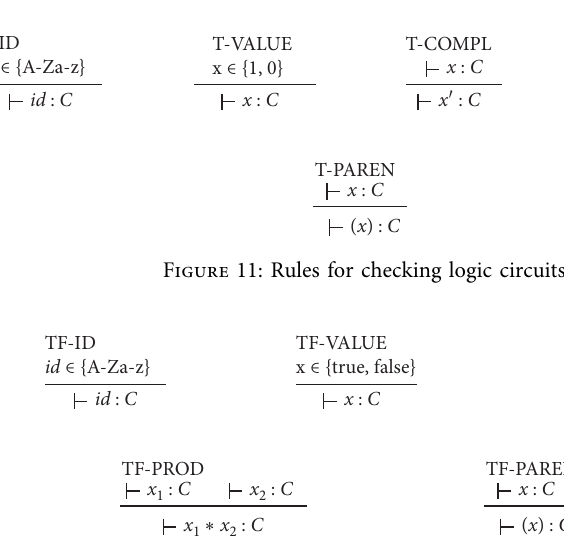
Figure 12: Rules for checking logic circuits in the output description language.